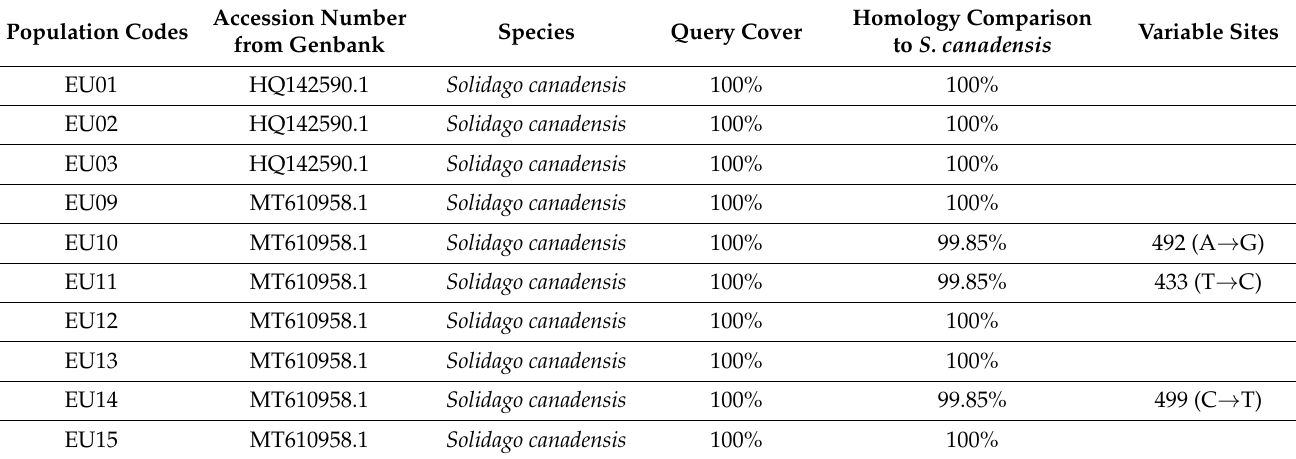
Table 1. Test of ITS sequences of Solidago canadensis blasted in NCBI